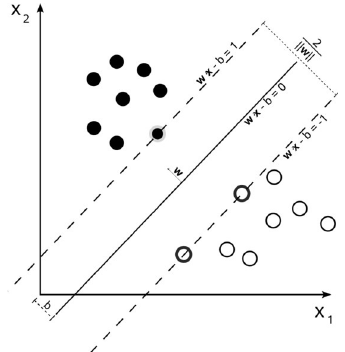
Figure 5. Hyperplane ( w , b ) equidistant to two classes, margin and support vectors.